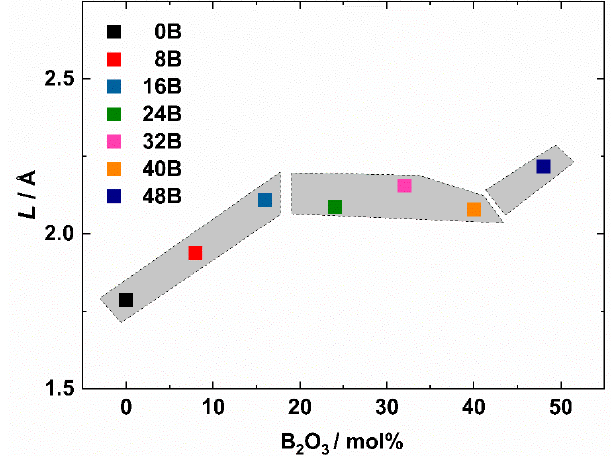
Figure 11. Sidebottom length as a function of B 2 O 3 content in (100 − x)[0.4Na 2 O-0.2Nb 2 O 5 -0.4P 2 O 5 ]- xB 2 O 3 , 0 ≤ x ≤ 48 mol%, glasses. The error bars are at most of the order of the symbol size.